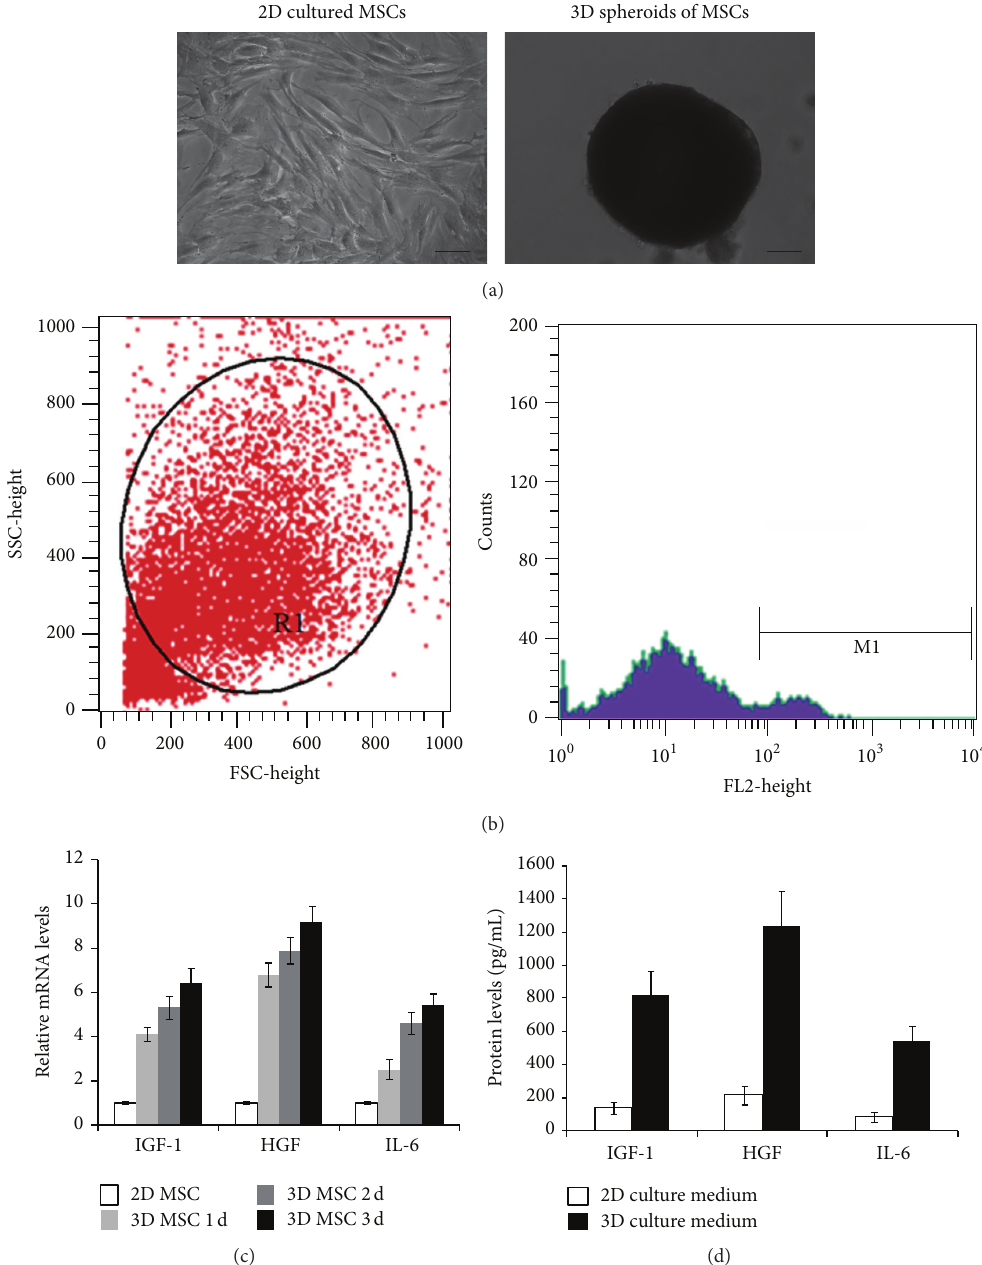
Figure 1: Morphology and paracrine secretions of human adipose-derived MSCs. (a) Morphology of 2D cultured MSCs and 3D spheroids of MSCs (bar = 100 𝜇 m). (b) Viability of 3D spheroid-derived MSCs. 3D spheroid-derived MSCs were stained with PI and analyzed by flow cytometry, indicating that the cell viability is over 90%. (c) Paracrine secretions of MSCs. The mRNA levels of IGF-1, HGF, and IL-6 in 3D spheroids of MSCs of different days and 2D cultured MSCs were determined by RT-PCR. GAPDH was the internal control. (d) The protein levels of IGF-1, HGF, and IL-6 in the conditioned medium of 2D cultured MSCs and 3D spheroids of MSCs were determined by